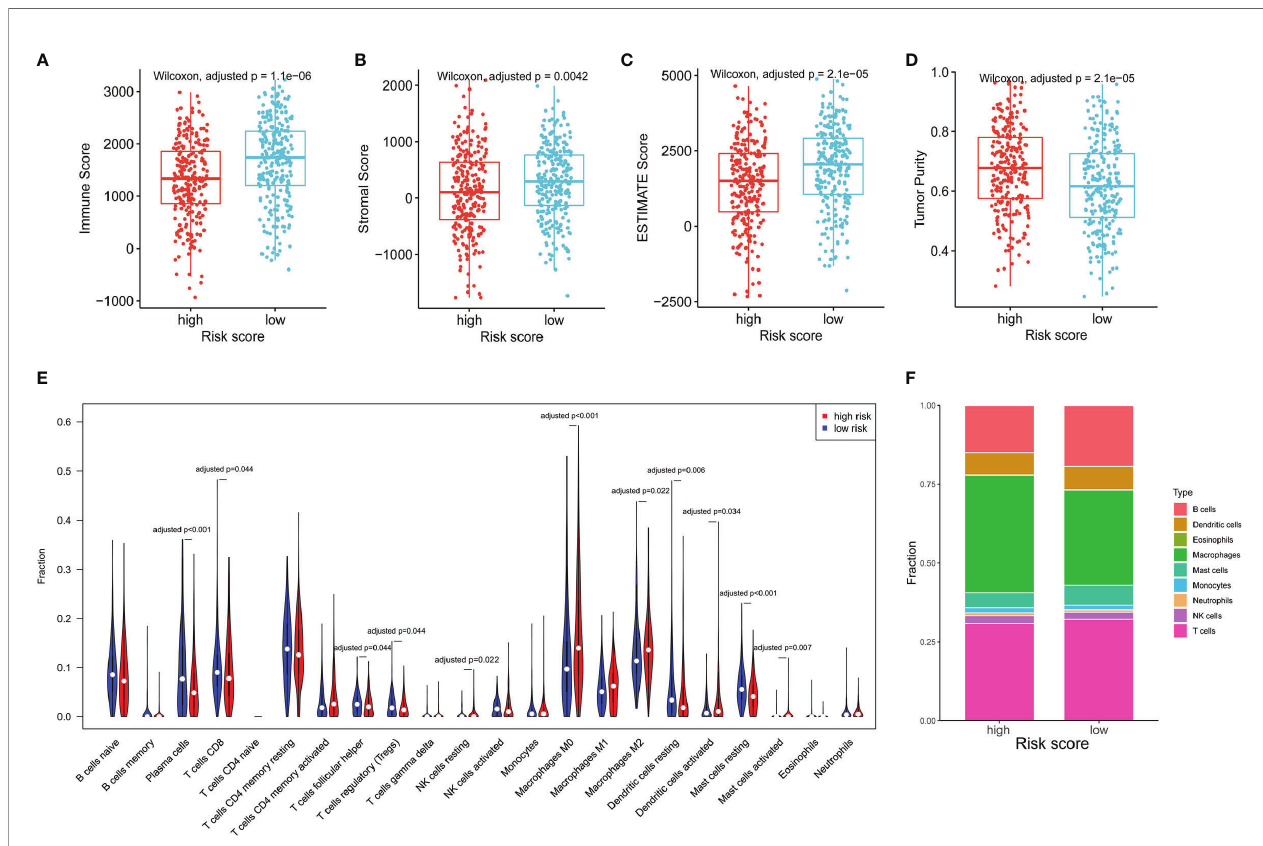
FIGURE 4 | The association between the NKCMGS and the immune cell in fi ltration in the TME. Differences among immune score (A) , stromal score (B) , ESTIMATE score (C) , and tumor purity (D) between high-risk and low-risk groups. The P-value was adjusted for 4 hypothesis tests. (E) The comparison of immune cells in fi ltration level of 22 immune cell types between high-risk and low-risk groups. (F) The fractions of different immune cells between high- and low-risk groups. The P-*value was adjusted for 22 hypothesis